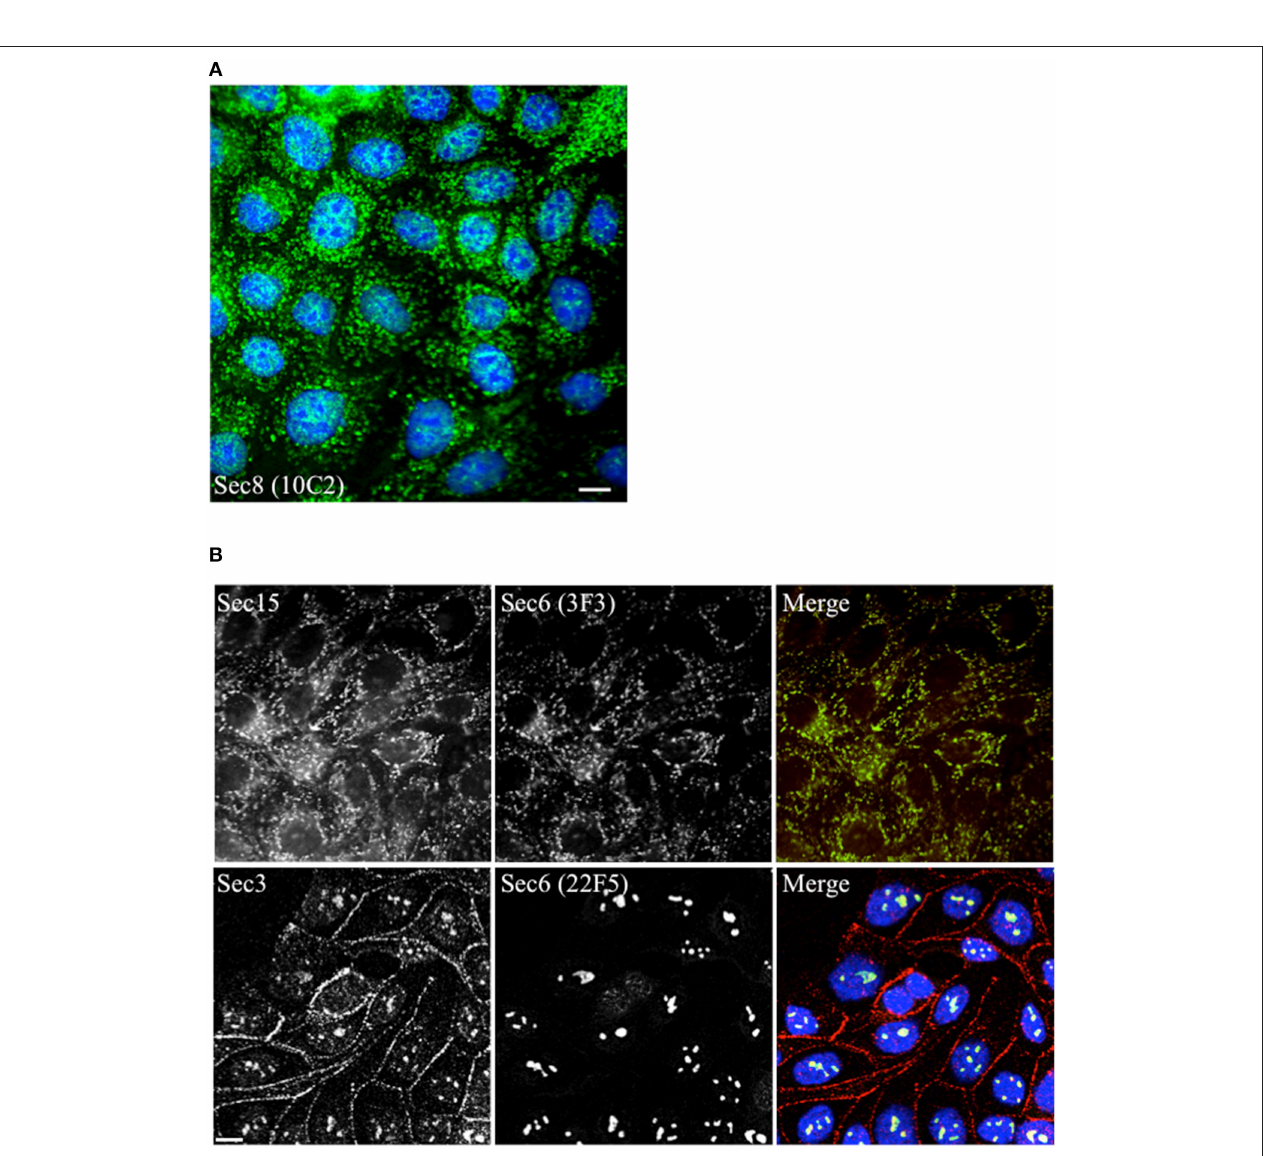
FIGURE 3 | Other exocyst subunits co-localize with Sec6 at sites labeled with subdomain-specific mAbs. Immunofluorescent labeling of MDCK cells with mouse monoclonal antibodies to Sec8 [mAb 10C2, (A) , green ] or Sec6 [either mAb 3F3, (B) top row, green or mAb 22F5, (B) bottom row, green ] and rabbit polyclonal antibodies to Sec15 [Rb. 96, (B) top row , red ] or Sec3 [Rb. 92, (B) bottom row, red ]. Cells were fixed with either 100% methanol [ (A,B) , top row] or were extracted with 1% Triton X-100 prior to fixation with 4% paraformaldehyde [ (B) , bottom row]. DNA was labeled with DAPI (blue). Bars = 10 µ m.